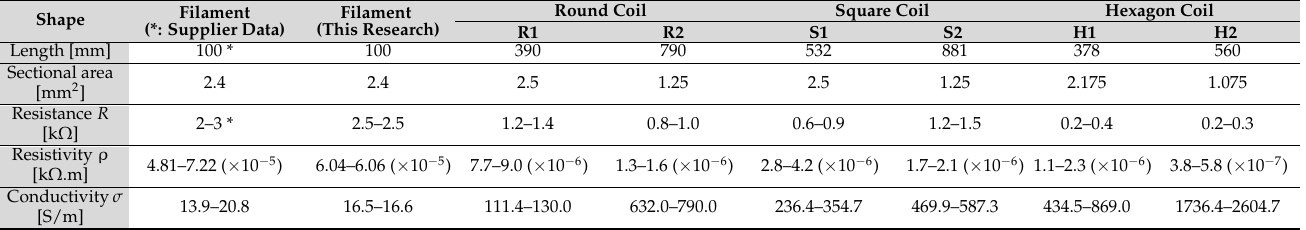
Table 1. Electrical conductivity and resistance data measured of test pieces (filament and printed). Filament Filament Round Coil Square Coil Hexagon Coil